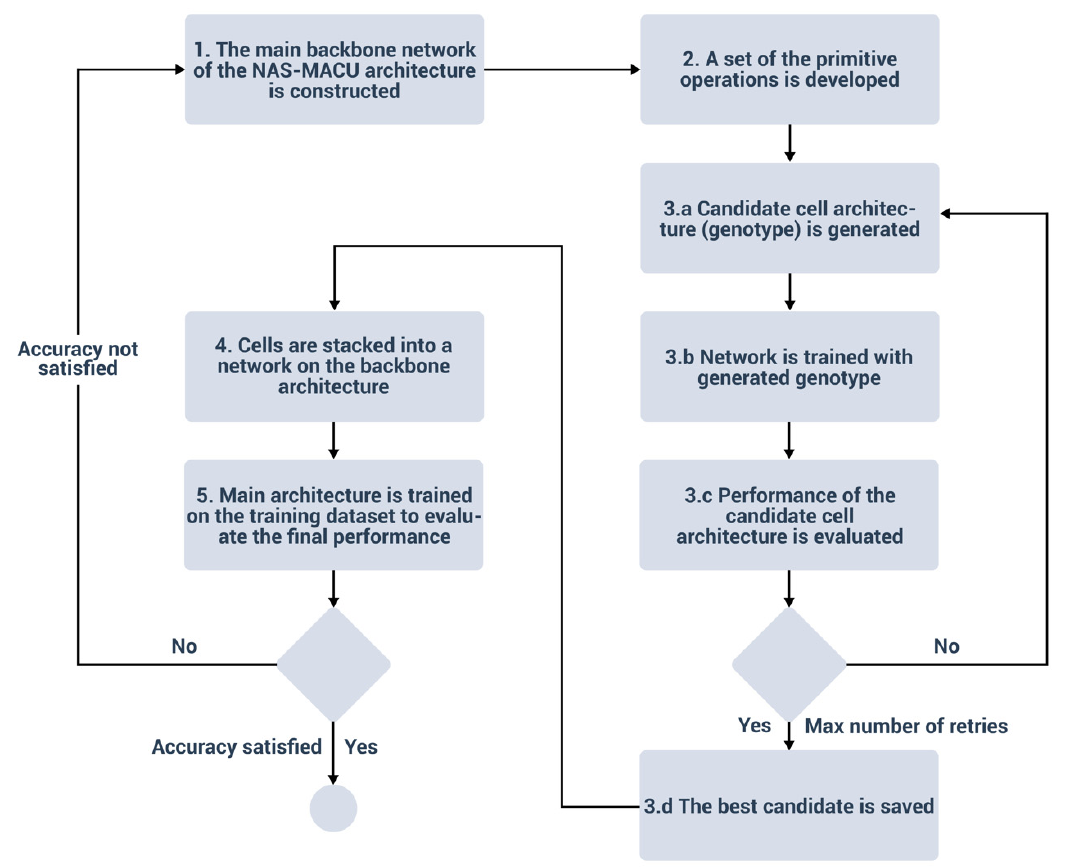
Figure 2. NAS-MACU construction process.